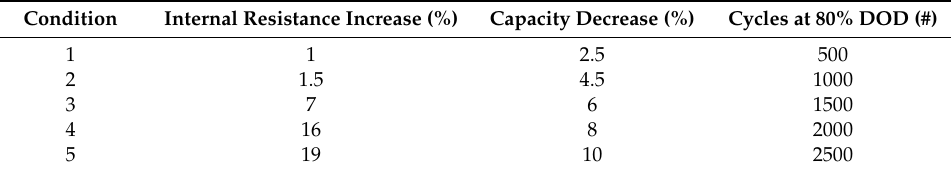
Table 5. Degraded battery performance test matrix based on [31,32].